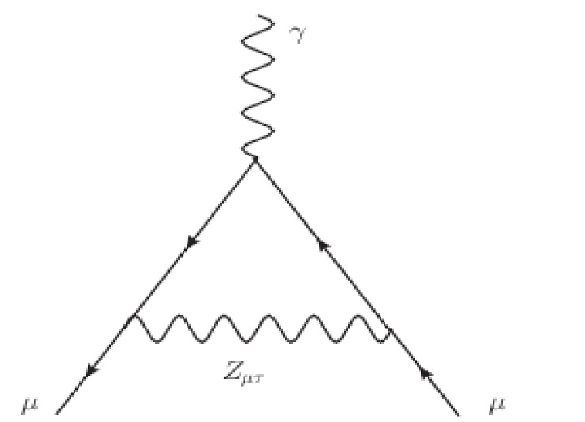
Figure 2 . One loop Feynman diagram for muon (g boson Z (cid:22)(cid:28)